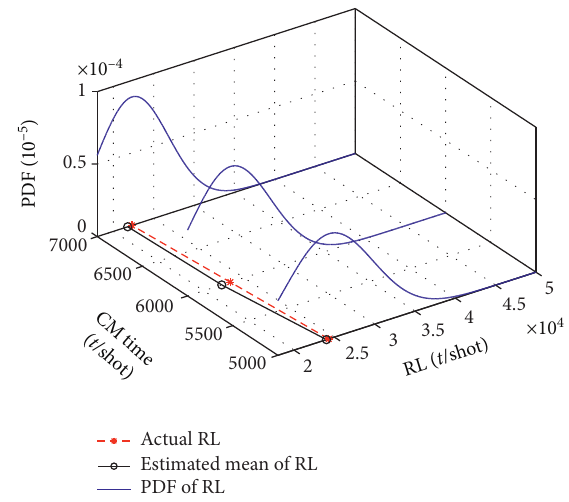
Figure 4: Probability density distribution of residual life (second stage). Table 5: Comparison of error for the estimation value of hyperparameters.